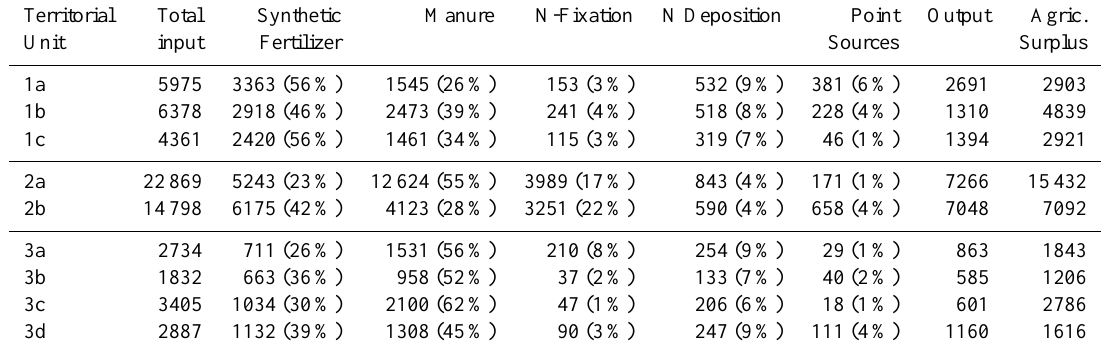
Table 2. Nitrogen inputs and outputs in the territorial units (kgN km − 2 y − 1 ) (The figures in brackets are the % of each input to the total inputs for each